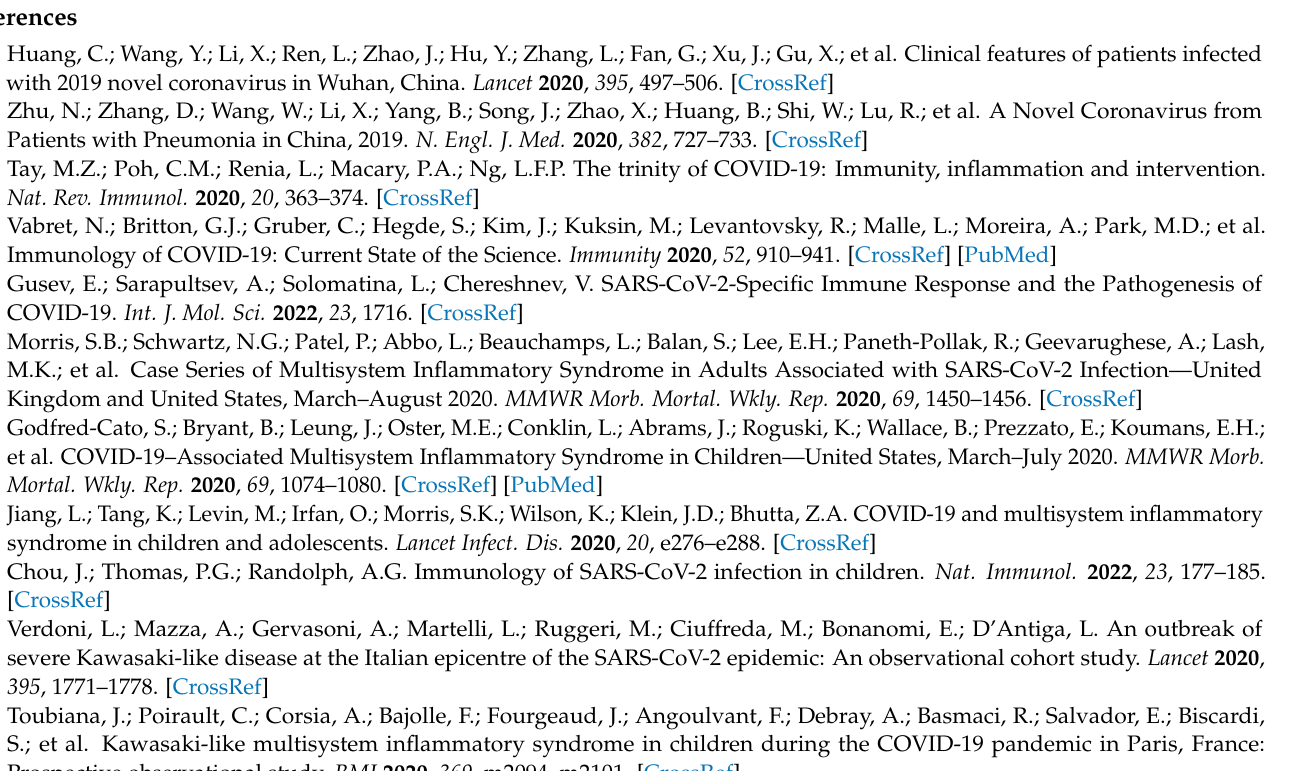
Figure S2: Comparison of SEB bound to 6D3 Ab and CD28, Figure S3: Top-9 ranking models of interaction between SARS-CoV-2 spike and αβ TCR, as predicted by ClusPro 2.0, Table S1: Results of Protein Docking between SARS-CoV-2 spike and TCR